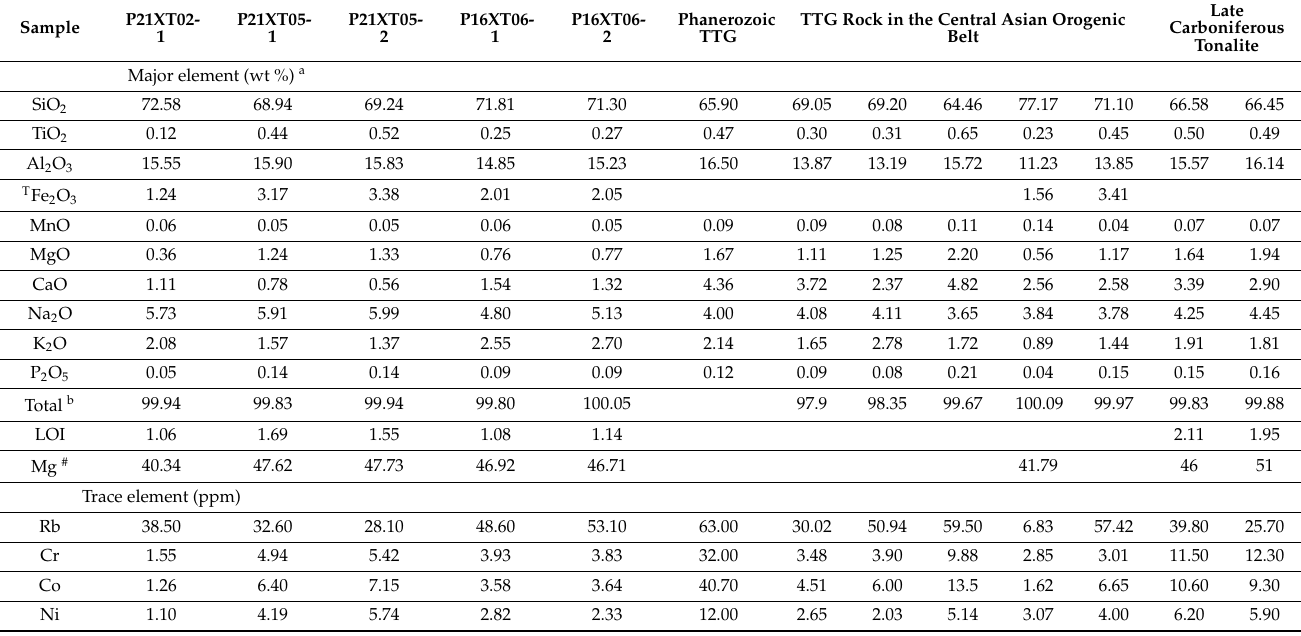
Table 1. Major and trace-element data for the Gaolihan